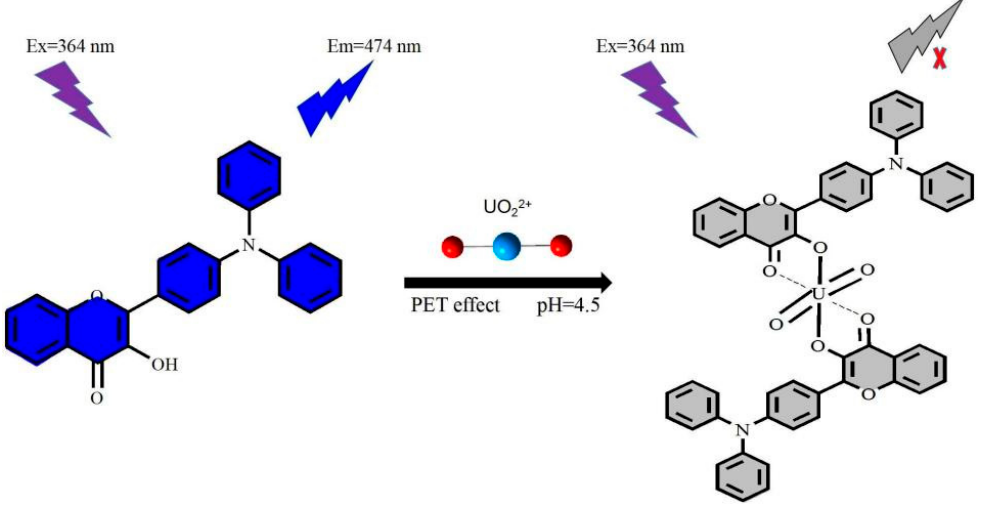
Table 2. Comparison of present work with the literature